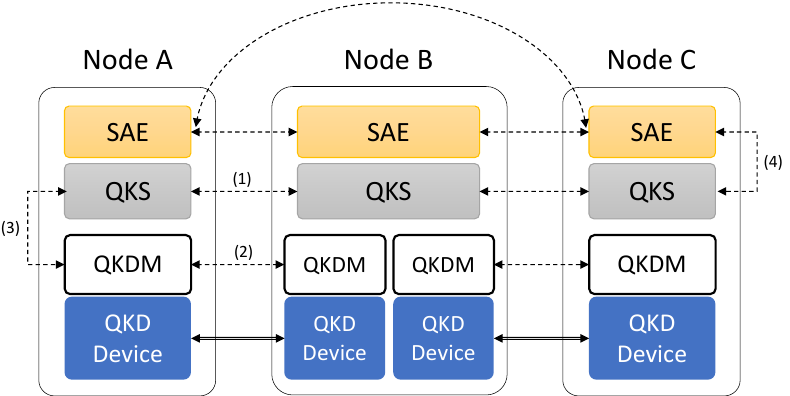
Figure 1. Quantum Software Stack (QSS) presented in [3]. Dashed lines represent TCP/IP secure connections. Thick, double lines indicate the combination of classical and quantum channel for the QKD exchange. The numbers enumerate the main interfaces: (1) External Interface; (2) Sync Interface; (3) Southbound Interface; and (4) Northbound